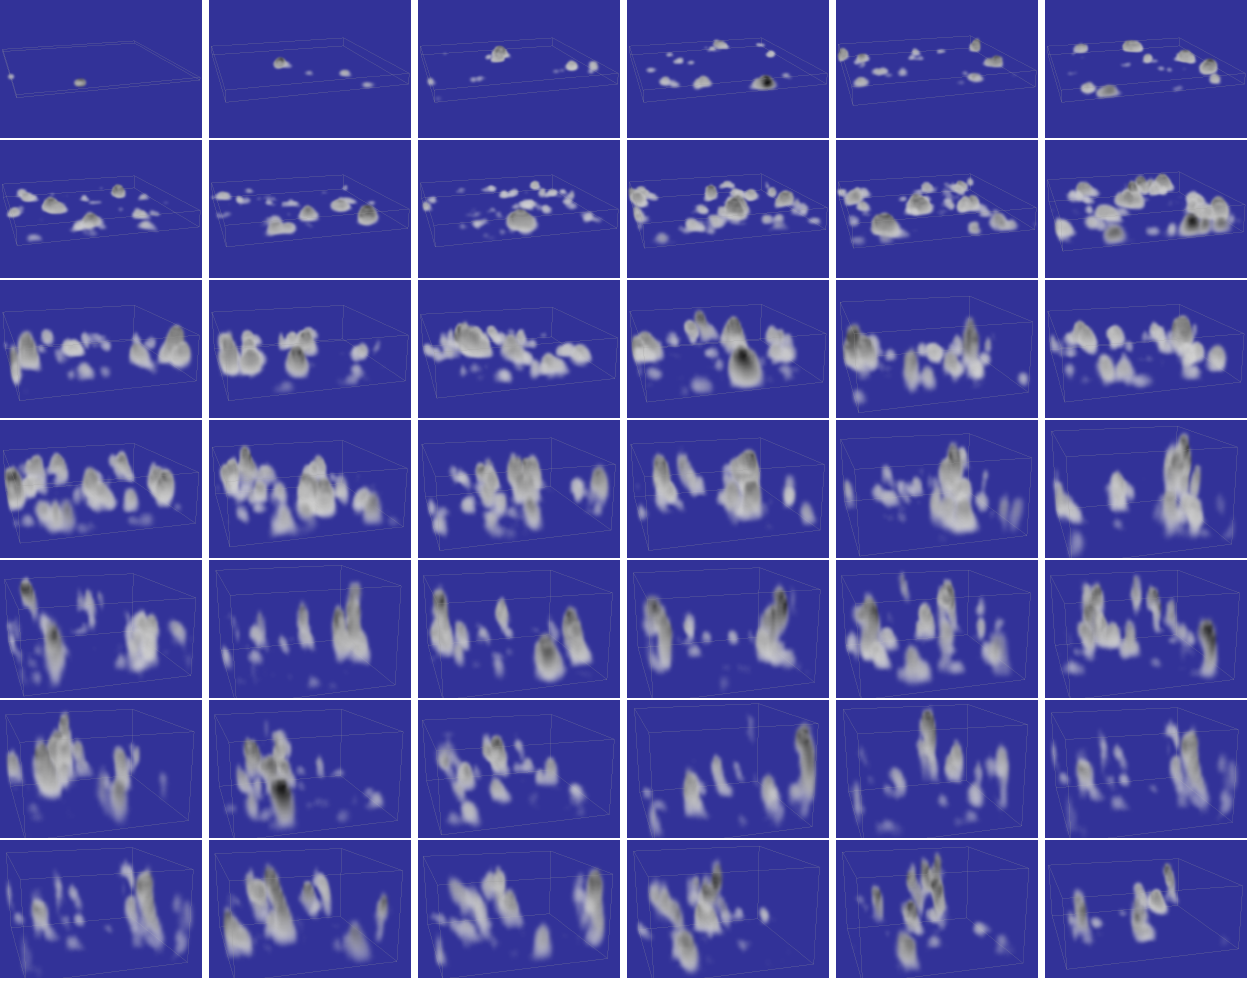
Fig. 3. Large eddy simulation of the diurnal cycle of shallow cumulus convection over SGP site of the ARM program (Brown et al., 2002). The snapshots represent the liquid water content fields (light/dark grey for lowest/highest LWC) sampled each 20min from 08:40UTC until 22:20UTC. slant perspective. The plotted sequence starts at 08:40 UTC (top left scene) and finishes at 22:20 UTC (bottom